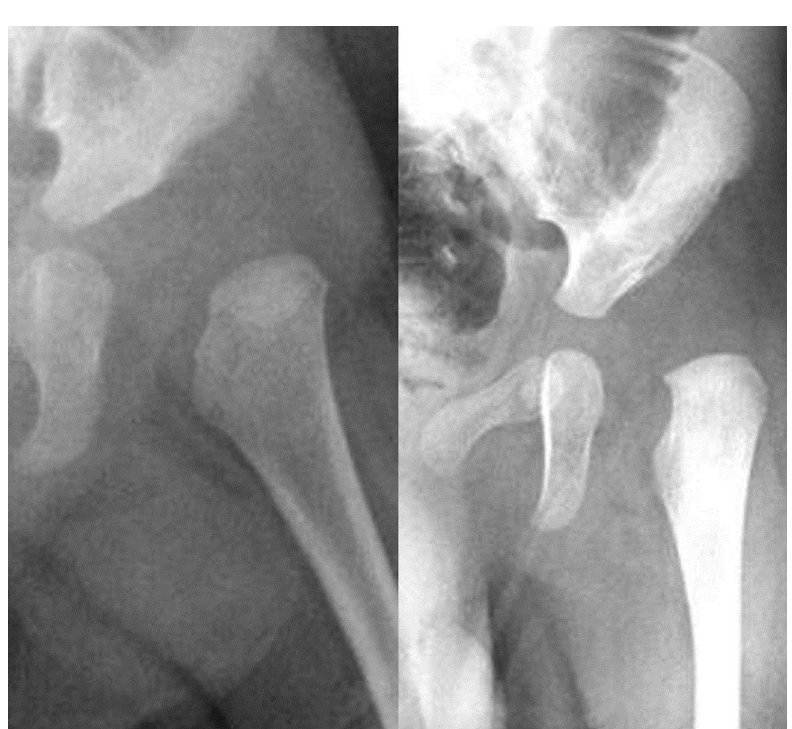
Figure 8. A 3-month-old girl with IHDI grade 3 DDH (left) and a 1-month-old girl with IHIDI grade 3 DDH (right). Both hips were correctly labeled as DDH, although epiphyseal ossification centers did not appear. DDH Developmental dysplasia of the hip, IDHI International Hip Dysplasia